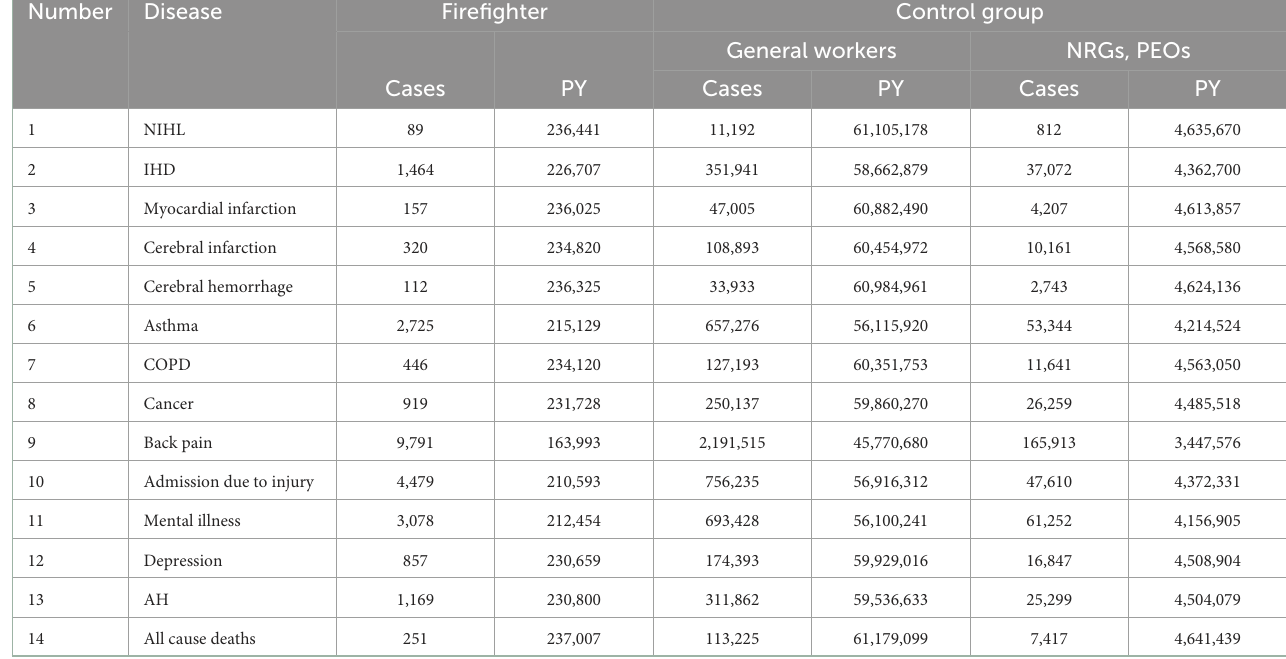
TABLE 2 Disease and person-year data of firefighters, general workers, national regional government officers, and public educational